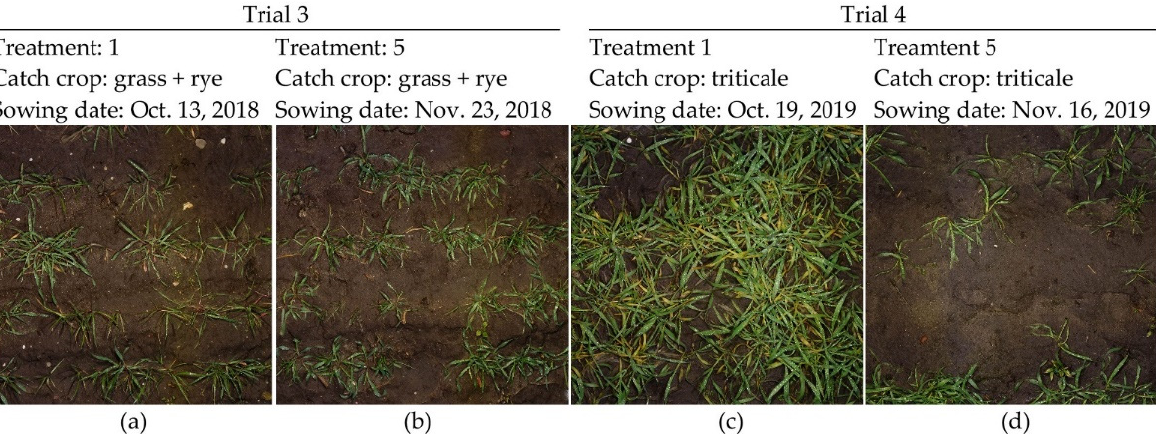
By postponing tillage from early autumn to early spring, spinach stubbles were able to continue to grow (Figure 7). Nitrogen uptake by spinach and a low net mineralization reduced the potential N losses by 47 or 61 kg ha − 1 in trials 2 and 3, respectively (Table 3). In contrast, in 2019/20 (trials 1 and 4) N losses were increased by up to 33 kg ha − 1 due to postponing tillage from autumn to spring. In these trials, spinach biomass decomposed partially or fully during autumn and winter, resulting in lower biomass N in spring com- pared to autumn. This is shown by the negative N uptake in trials 1 and 4 (Figure 5). This means that the amount of N in the spinach plants decreased from spinach harvest in au- Figure 6. Aboveground biomass at the end of February depending on the catch crop species grass + rye ( a , b ) and triticale ( c , d ) as well as the sowing date in early ( a , c ) and late ( b , d ) autumn.